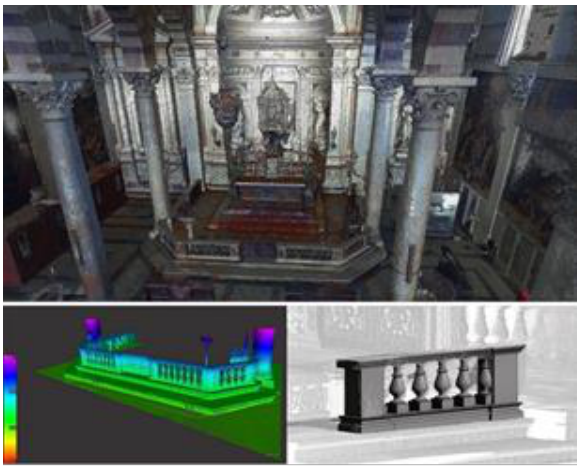
Figure 8. Some details of a ScanToBIM process as presented in the Master class: a marble balustrade from the Duomo di Santa Maria del Carmine in Pisa as inferred by a TLS point cloud for one of the main apses (Picture + BIM components by